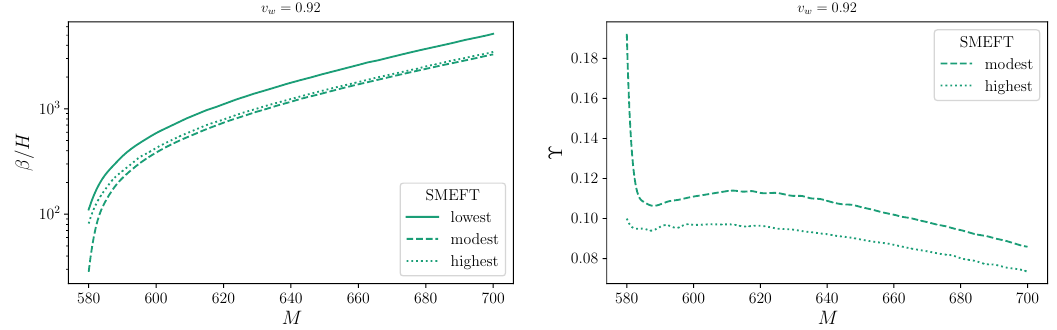
Figure 5 . SMEFT : the left panel shows the inverse time duration of the phase transition at the different levels of diligence using eq. [(2.6), (2.13), (2.37)]. The lowest and modest diligences are estimated using the first derivative of the action dS/dT and the highest diligence is computed directly from the mean bubble separation, eq. (2.31) and eq. (2.38). The right panel shows the suppression factor due to the lifetime of the source using eq. (2.14) and eq. (2.60) for modest and highest diligence respectively. The lowest diligence corresponds to Υ → 1 . The temperatures are set to T (2.4), T (2.11), and T (2.27) for the lowest, modest, and highest diligence n p f